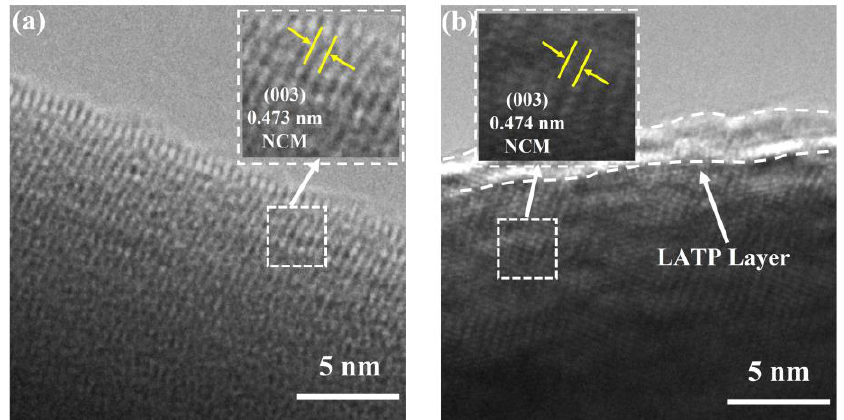
Figure 4. TEM images of ( a ) bare NCM and ( b ) NCM@0.5LATP. Surface compositions of bare NCM and NCM@0.5LATP were analyzed with